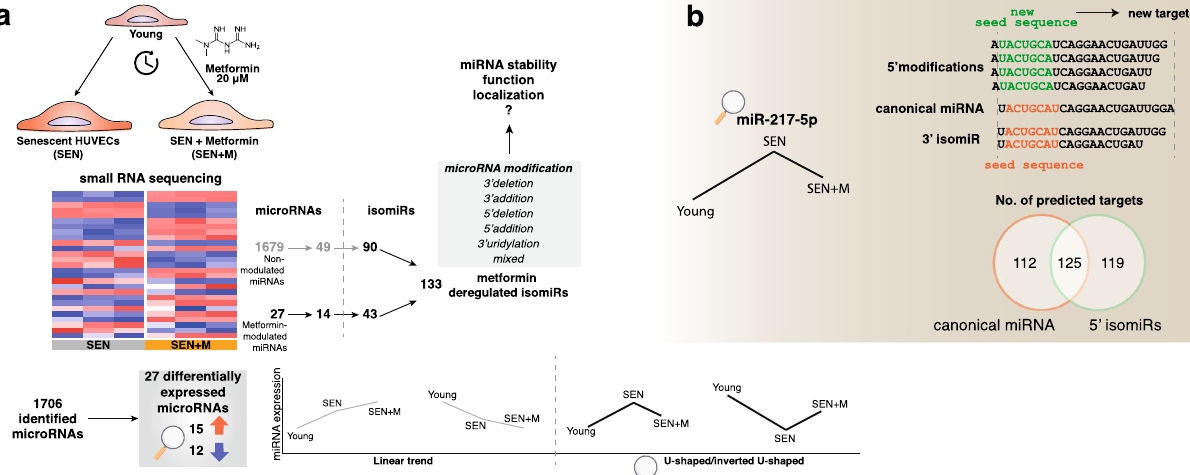
Figure 7. ( a ) Summary of the effects of metformin treatment on the miRNA/isomiR pool of HUVECs undergoing replicative senescence. Metformin differentially regulates the expression of 27 miRNAs. Two different trends in miRNA modulation were observed with reference to the Young/SEN/SEN + M sequence, i.e. a linear increasing/decreasing trend and a ‘U-shaped’/‘inverted U-shaped’ trend. Moreover, metformin treatment altered the expression of 133 isomiRs, related to 14 differentially expressed miRNAs and 59 non differentially expressed miRNAs. ( b ) Metformin treatment induced a partial reversal of the senescence-associated expression of miR-217-5p, including its 5 ′ isomiRs, which are associated to a shifting of the seed sequence. The inclusion of these additional seed sequences into the targetome analysis yielded a considerably greater number of target genes, most of which were not shared with the canonical